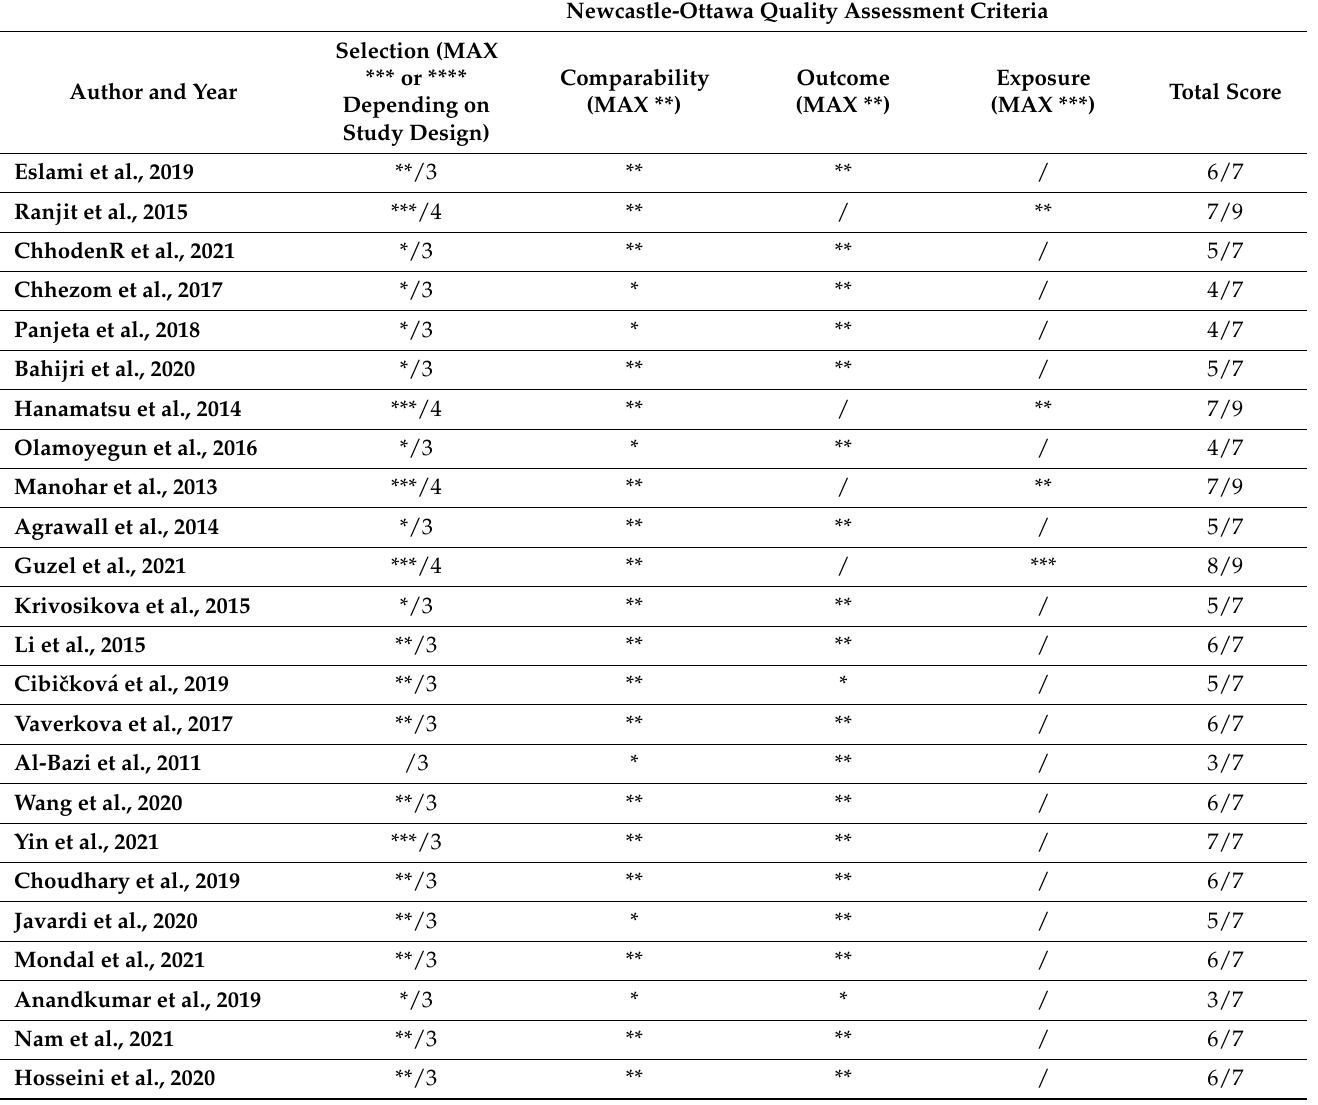
Table 2. Quality assessment of all 30 studies included using the Newcastle-Ottawa quality assessment scales for case–control studies and cross-sectional studies (adapted)